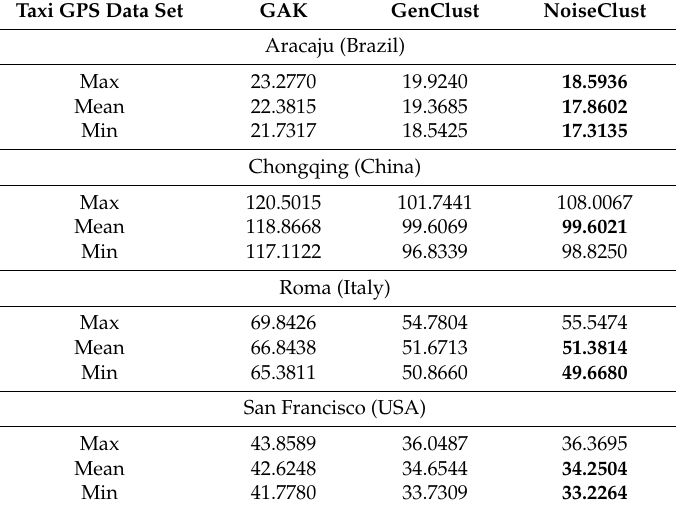
Table 4. The maximum, mean, and minimum values of the Sum of Squared Errors ( SSE ) obtained by the GAK, GenClust, and NoiseClust algorithms for 20 different runs for four real-would taxi GPS data